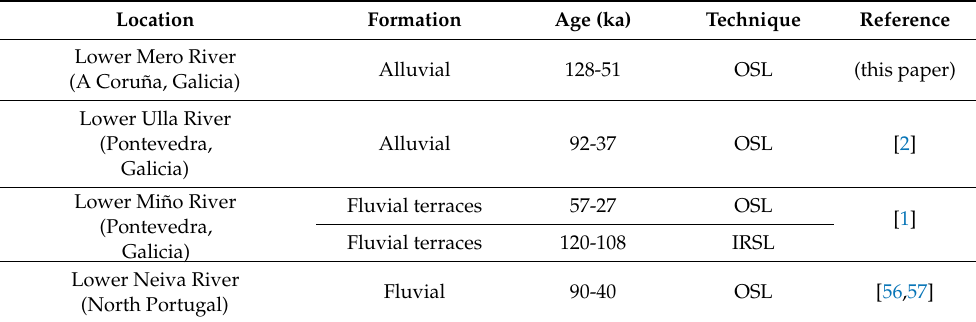
Figure 6. Chronology of alluvial deposits in the lower Mero River and global climate record for the last 120 ky. Temperature variation from Vostok ice cores [58] (grey line) and isotopic record (d18-O) from Greenland [59] (pink line). Global sea-level oscillations [60] (blue line). Age of alluvial and fluvial deposits on the Atlantic coast of Galicia dated by OSL and IRSL: lower Mero River (this paper), lower Ulla River [2] and lower Miño River [1]. Table 3. OSL and IRSL age ranges for coastal fluvial sediments on NW